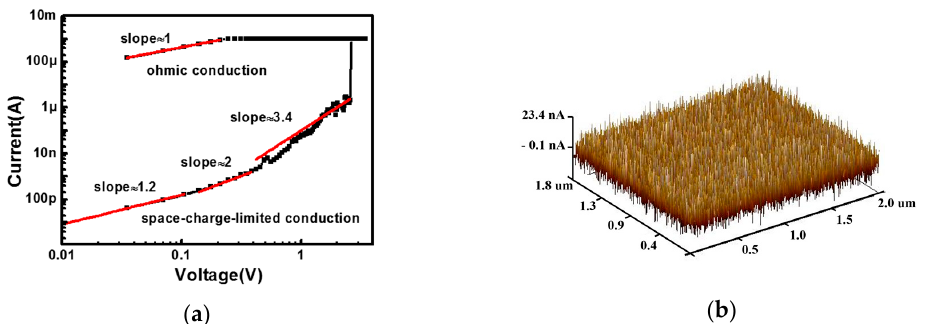
Figure 3. ( a ) The I-V curve with log-log scale from the set process. The low-resistance state (LRS) follows an ohmic conduction and the high-resistance state (HRS) follows a space-charge limited conduction (SCLC); ( b ) Current map of the fabricated conductive atomic force microscopy (CAFM) samples with an inert Pt electrode.